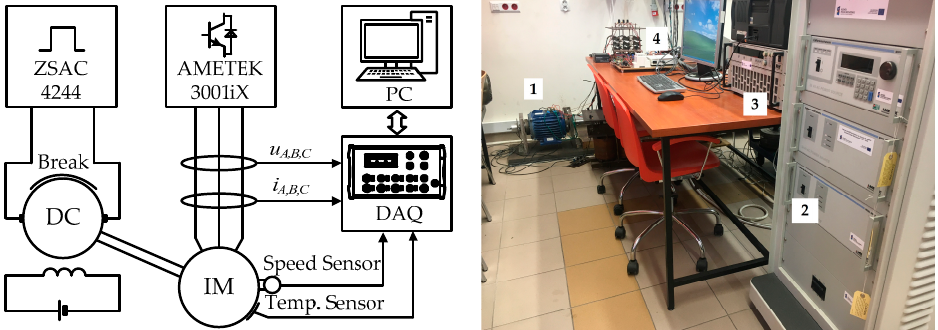
Figure A2. A schematic diagram and picture of the laboratory test bench: 1—tested IM; 2—programmable AC source AMETEK 3001iX; 3—programmable electronic load ZSAC4244; 4—DAQ.